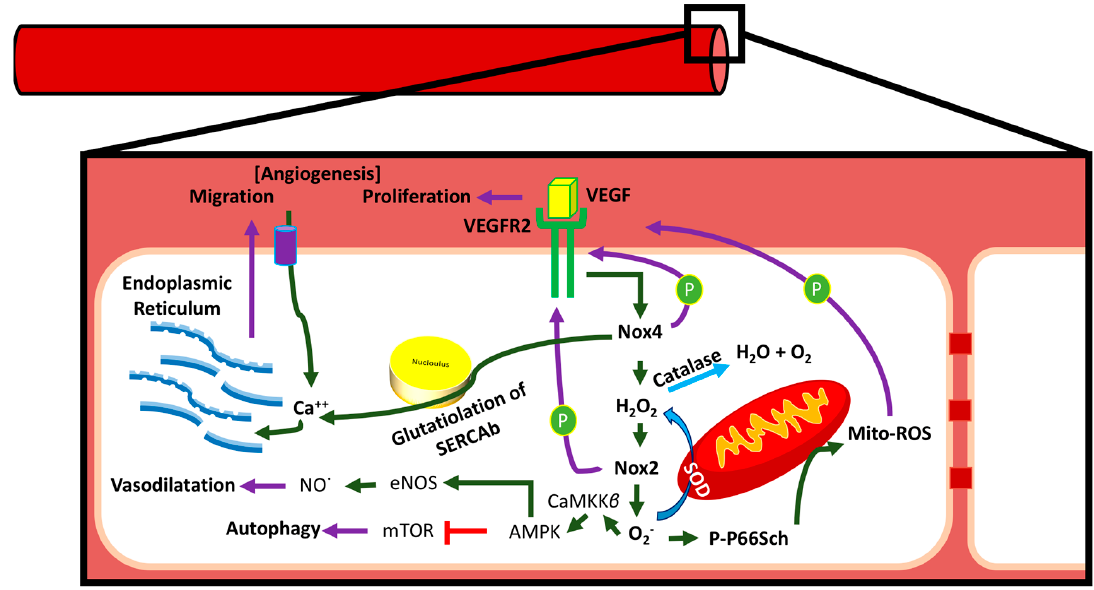
Figure 9. NADPH oxidase and NOX4 play major roles in endothelial ROS production and signal transduction. Endothelial ROS induces activation of eNOS to improve nitrogen oxide- cyclic guanine monophosphate (NO-cGMP)-mediated vasorelaxation, AMP-activated protein kinase- mammalian target of rapamycin (AMPK-mTOR)-mediated autophagy, glutathiolation of SERCAb-induced Ca ++ influx in ER and migration, and p66Shc-mediated modulation of mitochondrial ROS. Activation of VEGFR2 by VEGF leads to the activation of Nox4 and NADPH oxidase, resulting in intracellular redox signal activation. AMPK: AMP-activated protein kinase; CaMKK β : Ca2+/Calmodulin-dependent protein kinase kinase-beta; PP66Sch: phosphorylated-P66Sch.